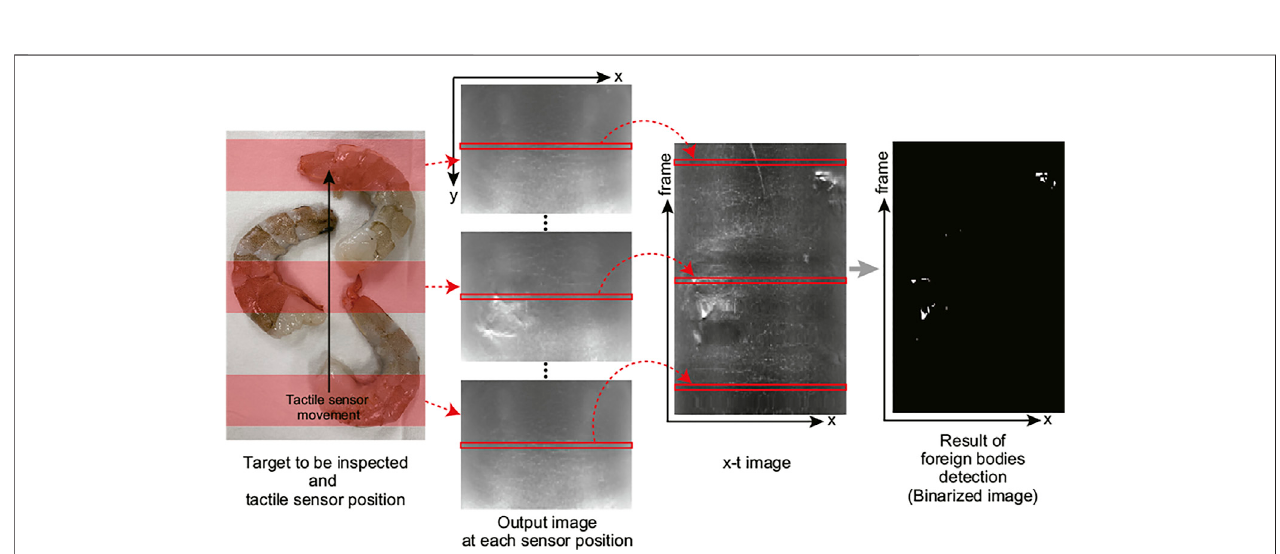
FIGURE 5 | Tactile image processing for detecting foreign bodies in the proposed cylindrical tactile image sensor.